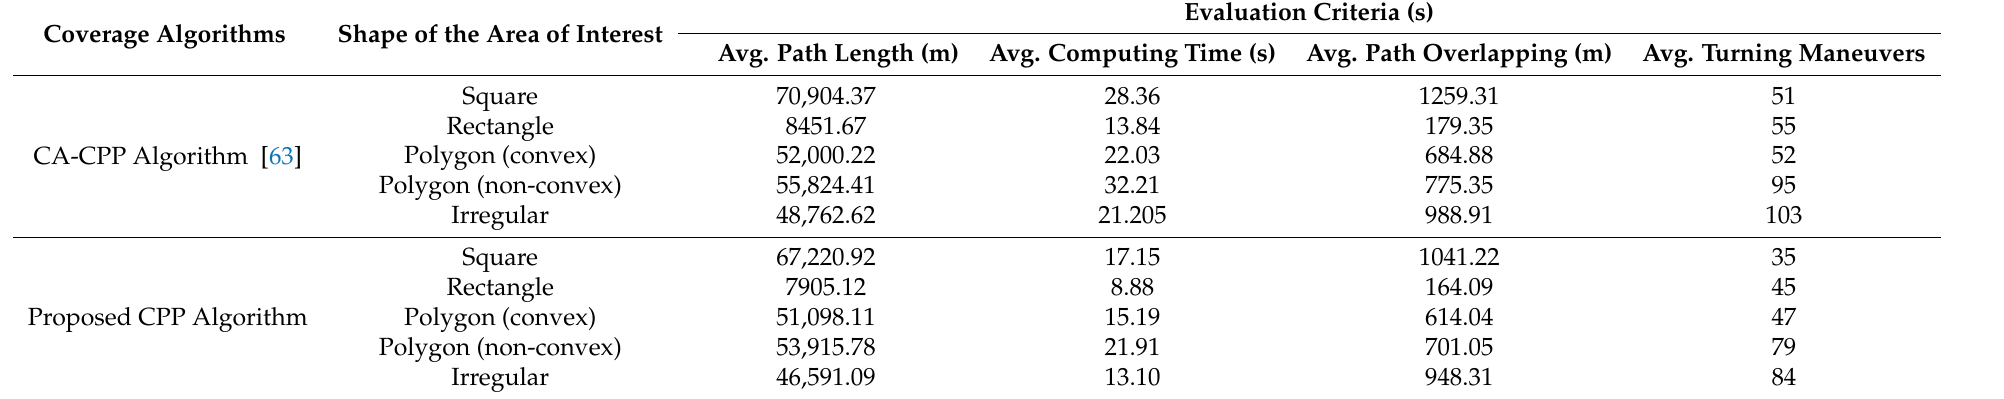
Table 5. Comparison of the proposed algorithm performance with varying shapes of the area of interest.